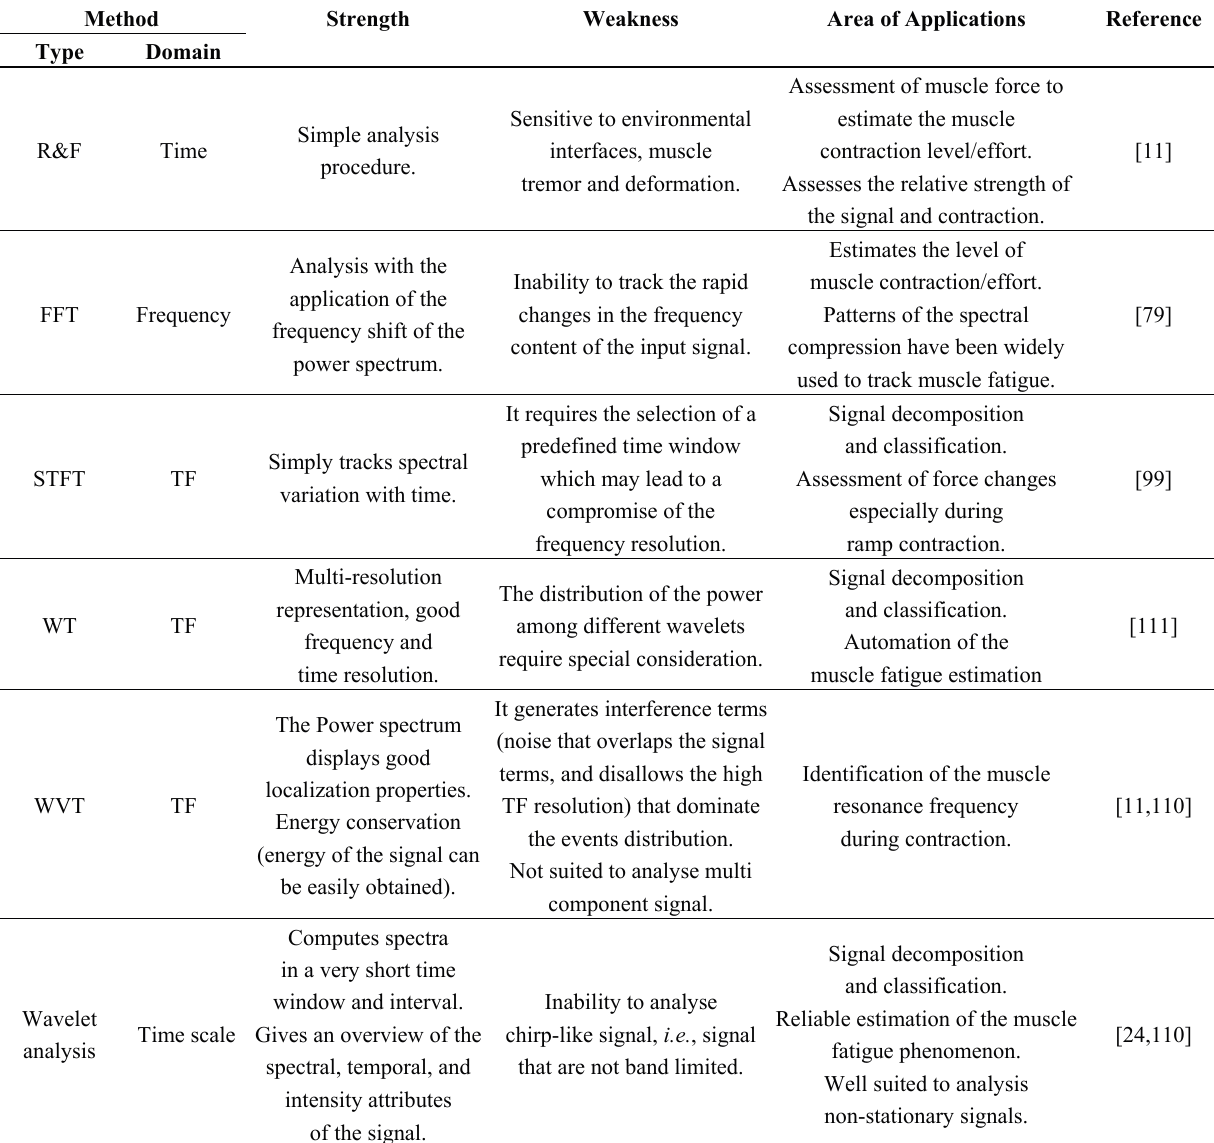
Table 1. Summary of the common MMG signal features extraction